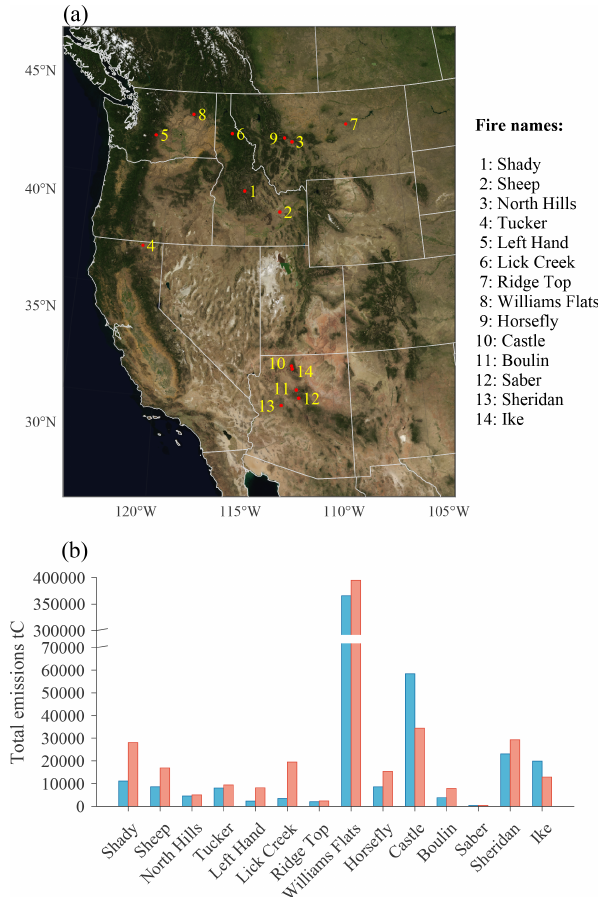
Figure 13. (a) Location of the 14 fires selected from the Fuel2Fire dataset specifically designed for the FIREX-AQ campaign, overlaid by a Blue Marble image from NASA. (b) Total carbon emissions (tC) from Fuel2Fire (blue bars) and VFEI (red bars). Note the bro- ken y axis. Table S1 shows the date(s) of occurrence of each of these